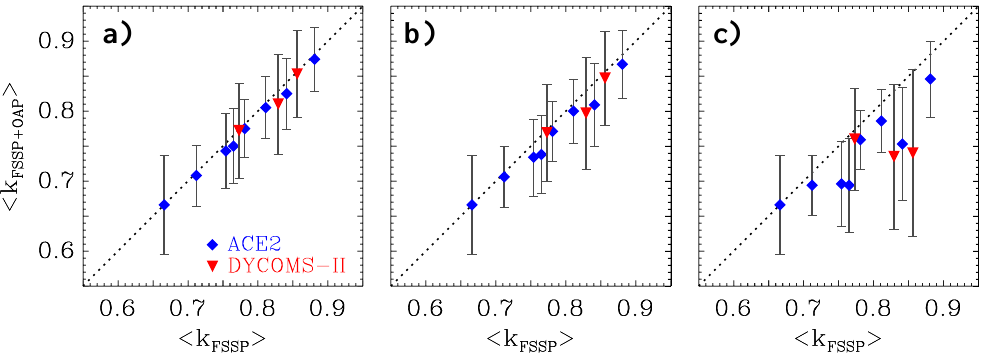
Fig. 2. Scatterplot of the mean flight k values as derived using the size spectra extended with the drizzle probe with an upper limit set to (a) 55µm, (b) 75µm, and (c) the nominal upper diameter range of the probe (310µm for the OAP-200X in ACE-2, and 635µm for the OAP-260X in DYCOMS-II), against the values derived using the droplet probe only. Error bars correspond to one standard